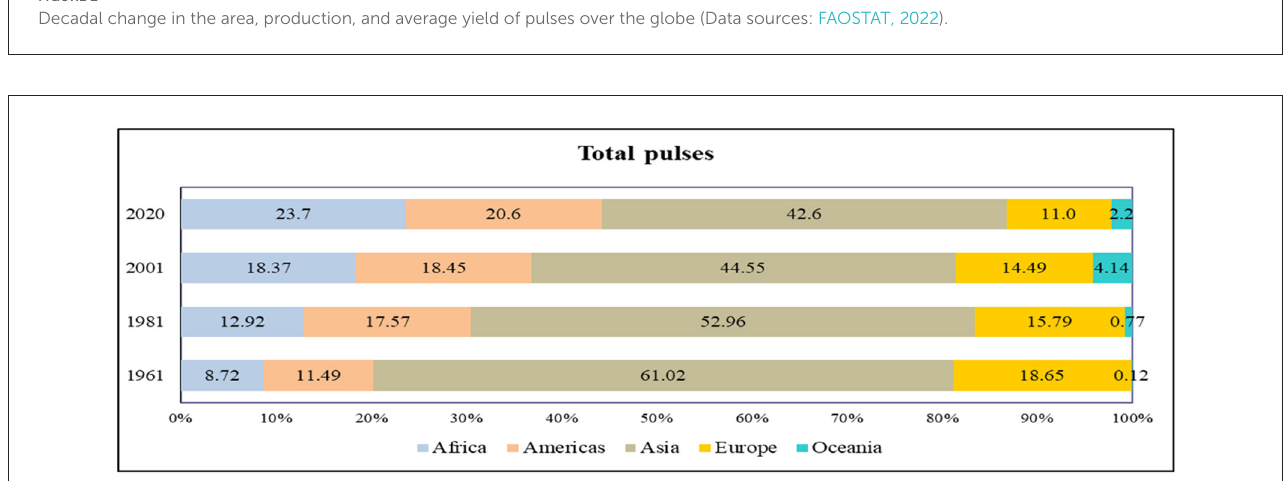
FIGURE3 Continent-wise share in the global pulse production, ending 1961, 1981, 2001, and 2020 (in percentage) (Data Sources: FAOSTAT, 2022).